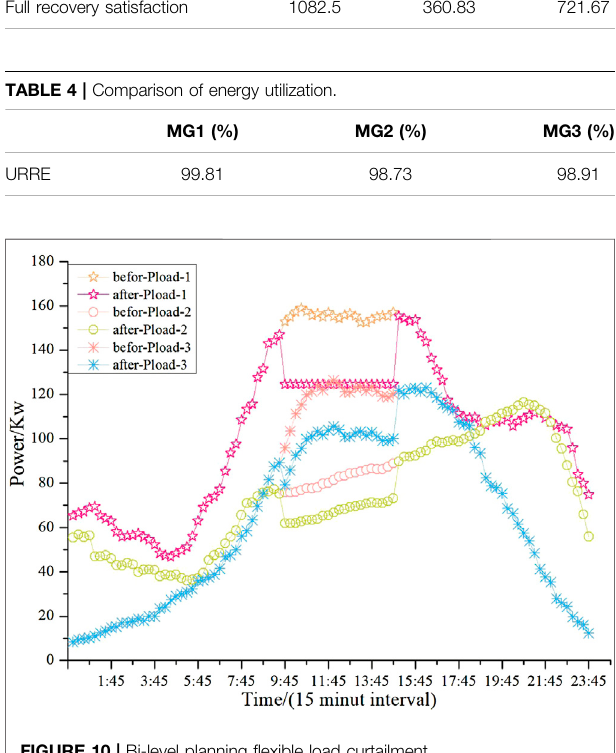
Figure 5 . The intermittent RE of MG 1 occurs at 10:00 – 15:00, resulting in the fault shutdown of the WT and PV generator. The installed capacity of each unit of MG is shown in Table 1 . The experimental environment uses Intel (R) Core (TM) i7-6700hq CPU